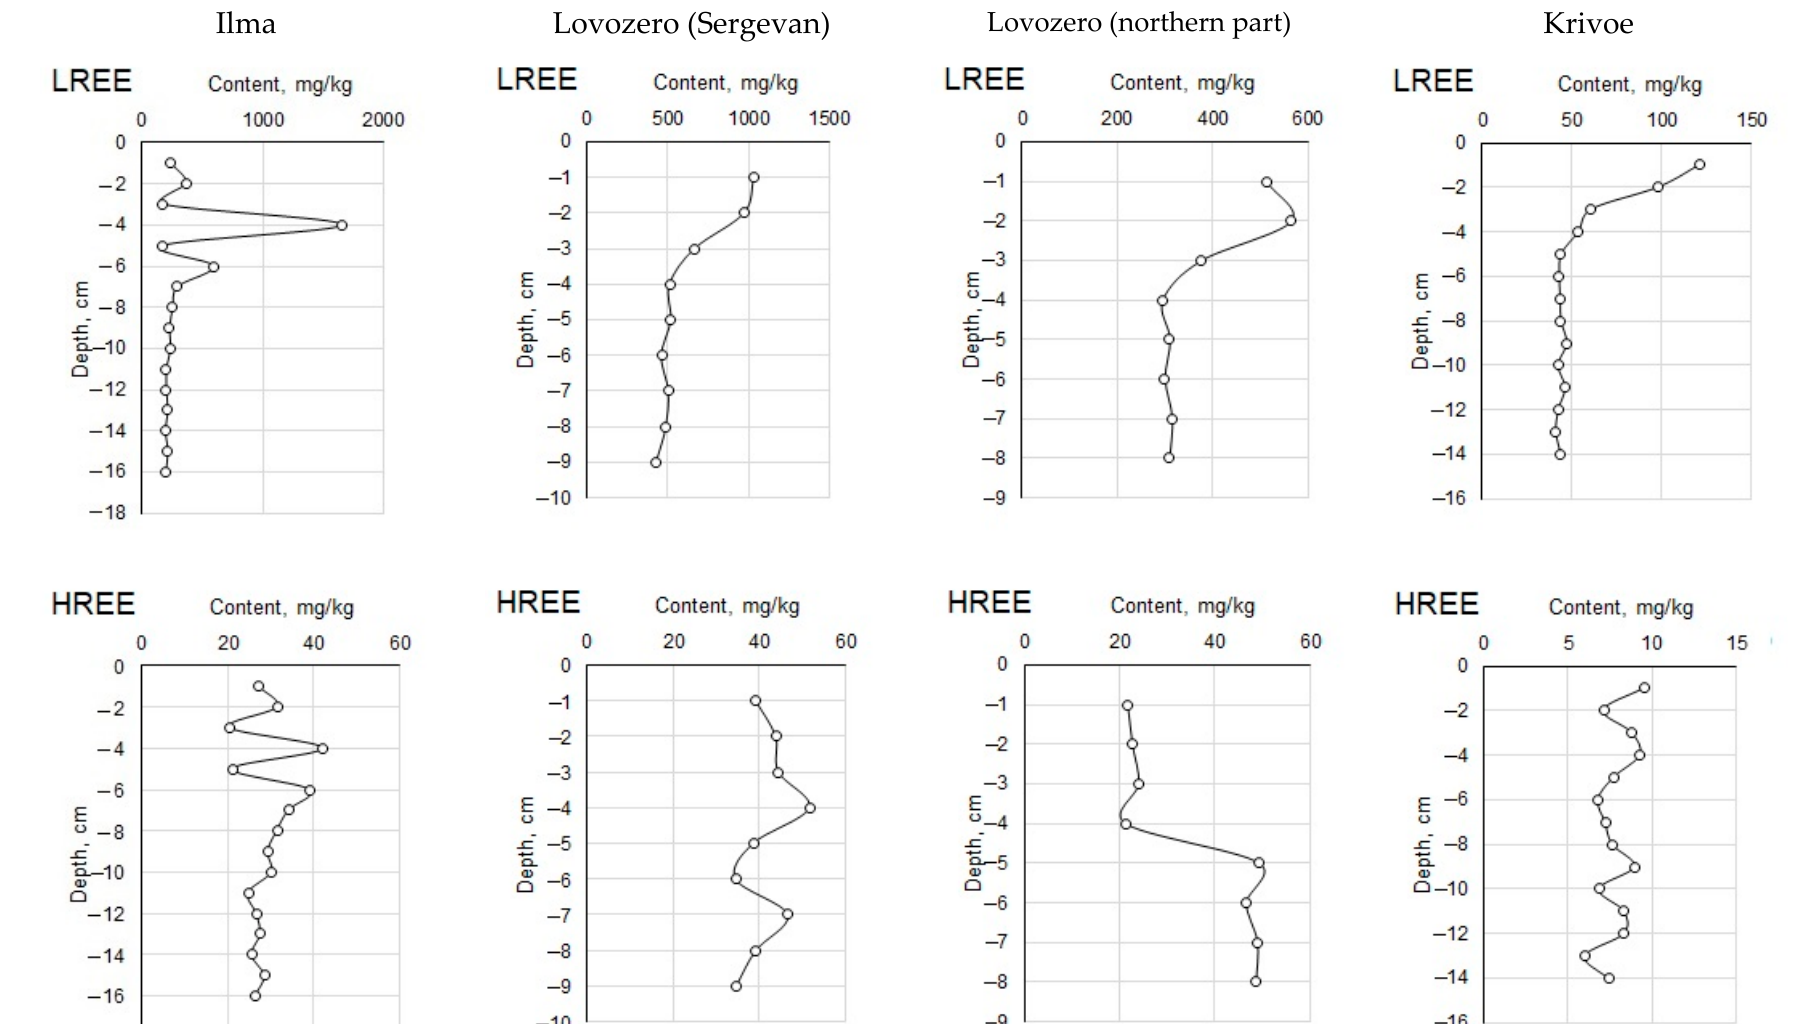
Figure 3. The vertical distribution of the content of REEs (LREEs and HREEs) in the selected samples of BS of lakes.